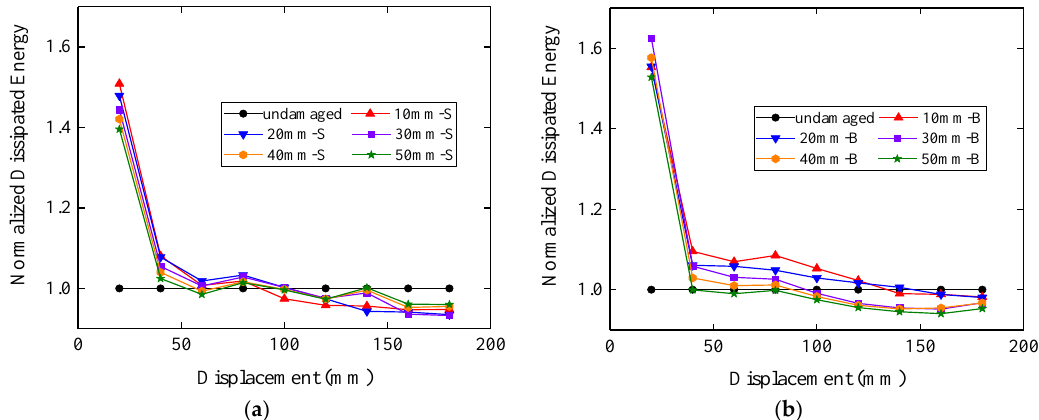
Figure 19. Normalized dissipated energy: ( a ) Single joint damaged models; ( b ) both joints damaged models.